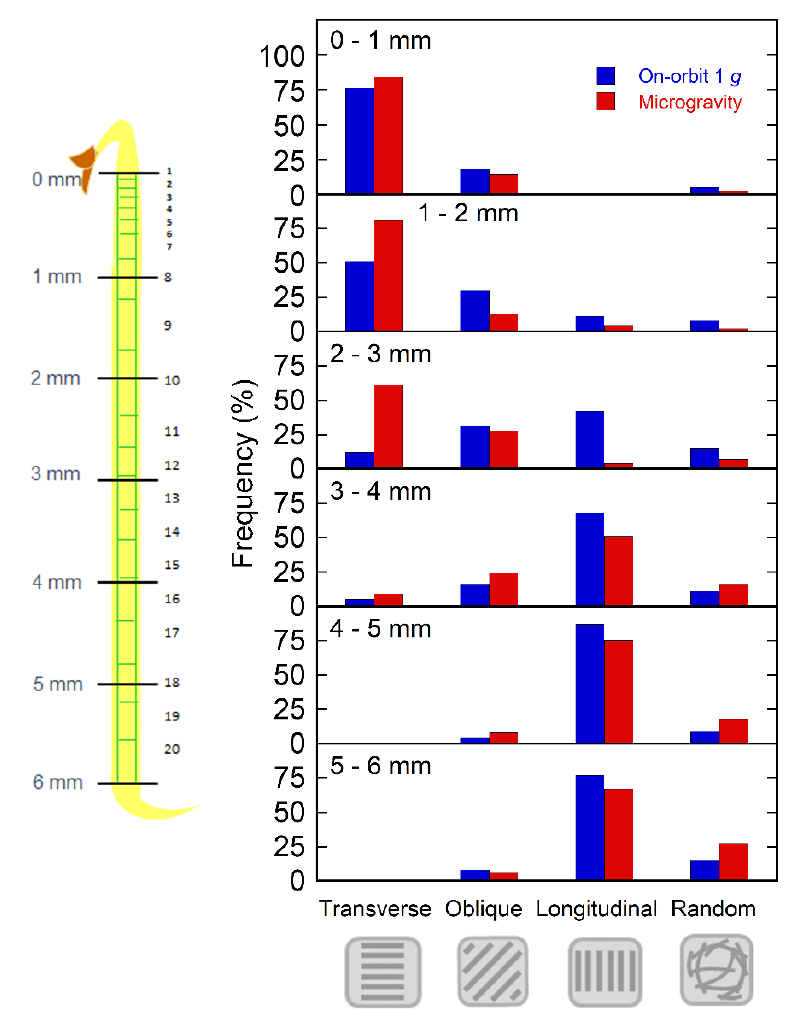
Figure 2. The orientation of cortical microtubules in epidermal cells of Columbia hypocotyls. Seedlings were grown as described in Figure 1 and cortical microtubules were stained and observed as described in Materials and Methods. The orientation of cortical microtubules adjacent to the outer tangential wall of the epidermal cell was determined. The frequency (percentage) of cells with cortical microtubules within a range of 0–30° (transverse), 30–60° (oblique), or 60–90° (longitudinal) with respect to the transverse cell axis, and in a variety of directions (random) was calculated for 200 cells in every 1 mm region from the tip to the base. In 1–2 and 2–3 mm regions, the proportion of four categories of cortical microtubule orientation was significantly different between the on-orbit control and microgravity ( p < 0.05).